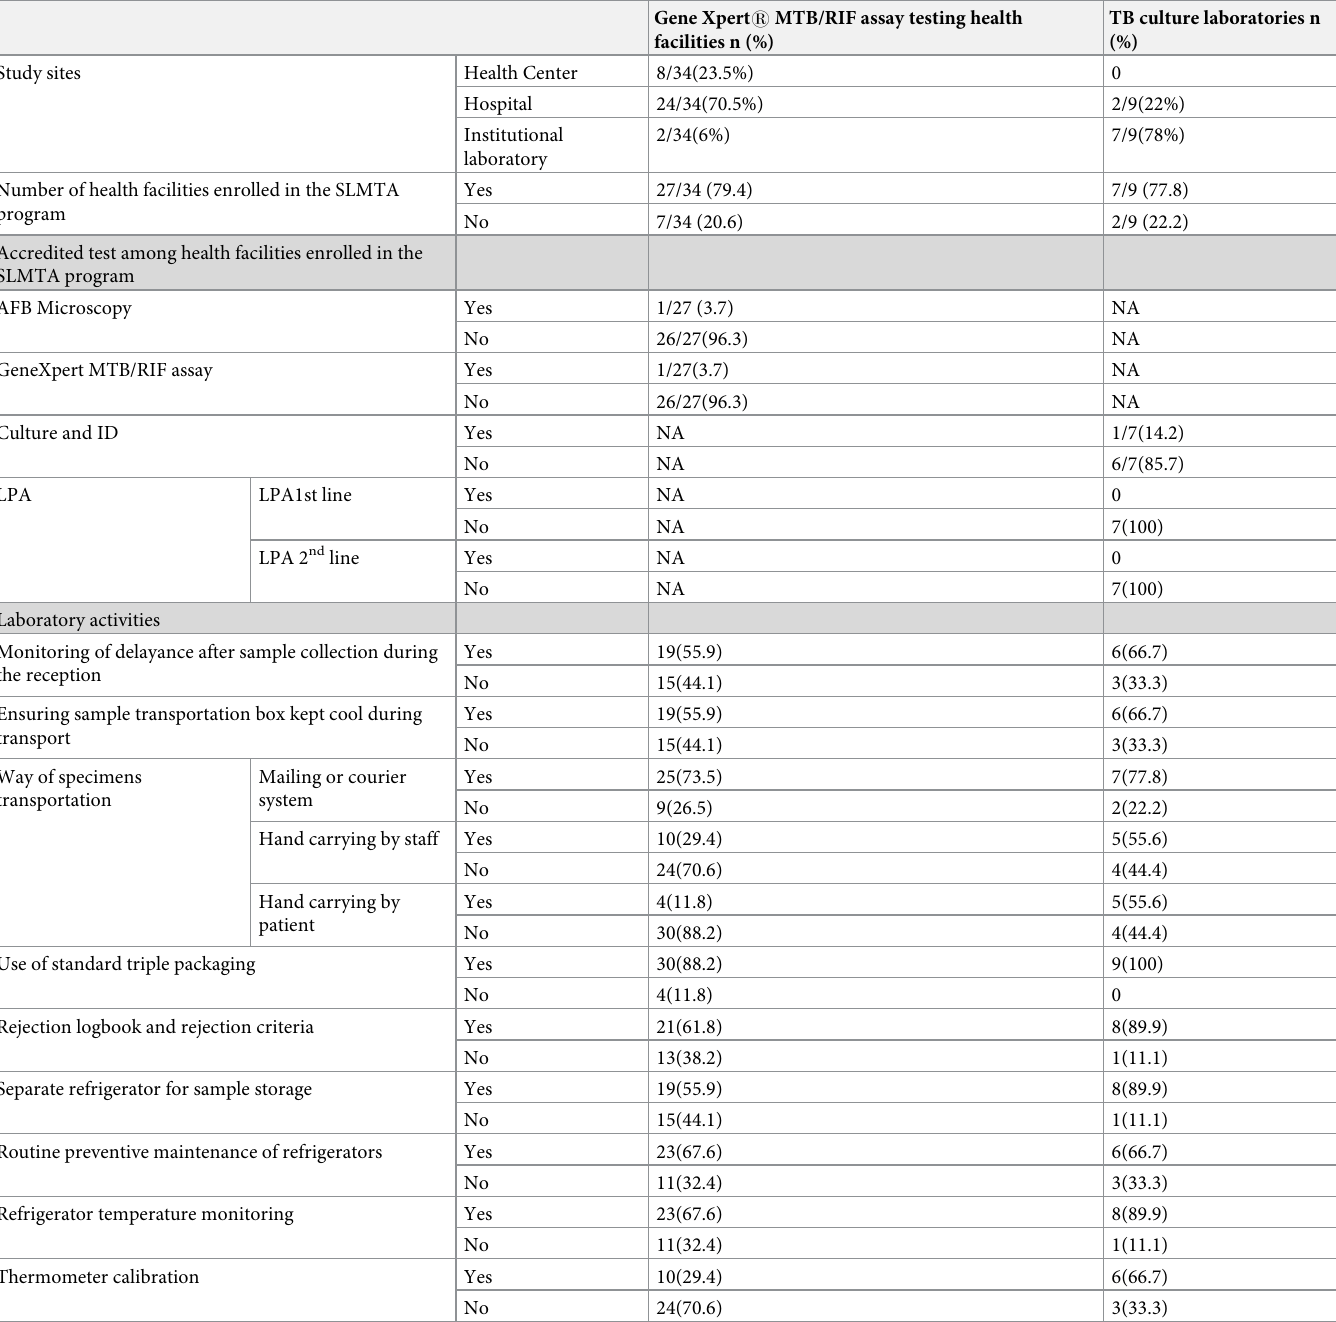
Table 1. General information on quality assurance practice in TB culture laboratories and Xpert testing health